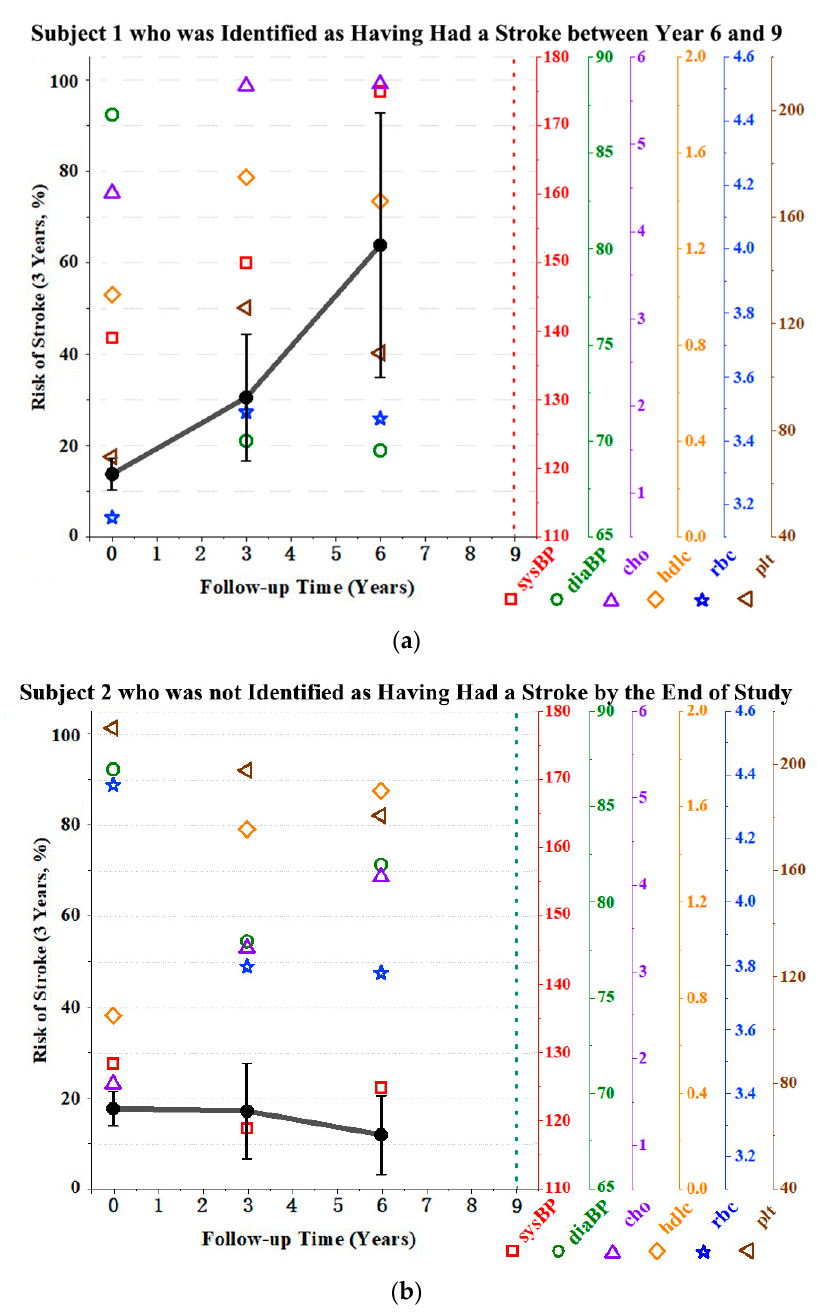
Figure 4. Dynamic risk of stroke prediction for two representative cases. ( a ) Personalized dynamic prediction plot for Subject 1, who was identified as having had stroke between 2014 and 2017; ( b ) personalized dynamic prediction plot for Subject 2, who was not identified as having had a stroke until the end of study (2017). Follow-up years of 0, 3, 6, and 9 equate to 2008, 2011, 2014, and 2017, respectively. The left y -axis is the three-year risk of stroke. The right y-axes are values of longitudinal risk factors: sysBP—systolic blood pressure (mmHg); diaBP—diastolic blood pressure (mmHg); cho—total cholesterol (mmol/L); hdlc—high-density lipoprotein cholesterol (mmol/L); rbc—red blood cell count (10 12 /L); and plt—platelet count (10 9 /L). Black dots indicate the three-year risk of stroke at each measurement. Connected plain black lines represent the risk change trend. The verti- cal interval of each point is the confidence interval calculated by repeated 10-fold cross-validation. The vertical red dotted line is the time point of being diagnosed with a stroke and the vertical green dotted line is the end of the observation time.